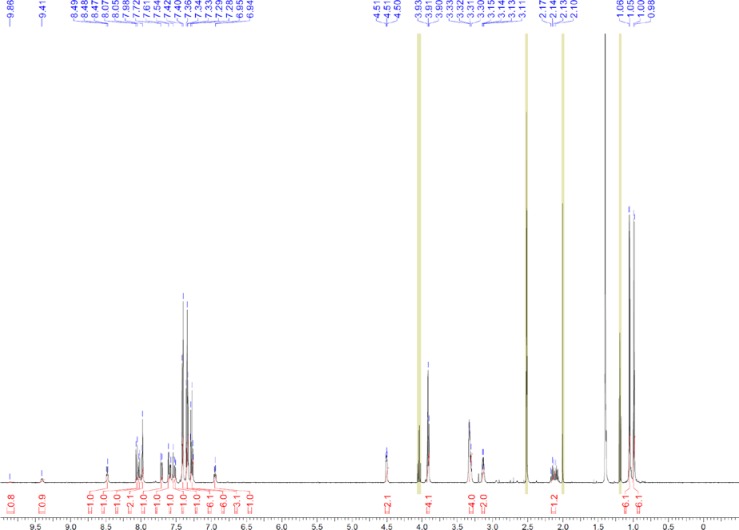
1H NMR of compound 12.